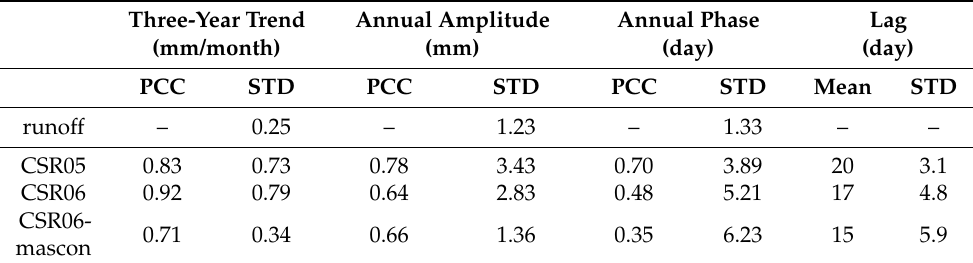
Table 1. The cross-correlation (PCC) between runoff and EWHs and their standard deviation (STD) from 2005 to 2012 in terms of three-year trend, annual amplitude and annual phase, in addition to the mean and STD of the time lag calculated by the annual phase difference between runoff and EWHs. Three-Year